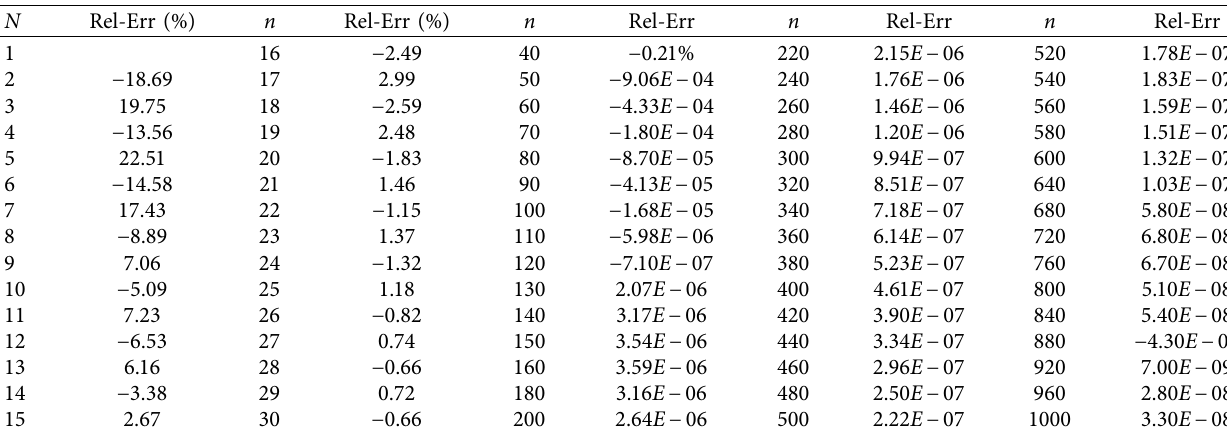
( n ) when 1000 ≤ n ≤ 10000, step 300. g 2 ( n ) to h ( n ) when n ≤ g 2